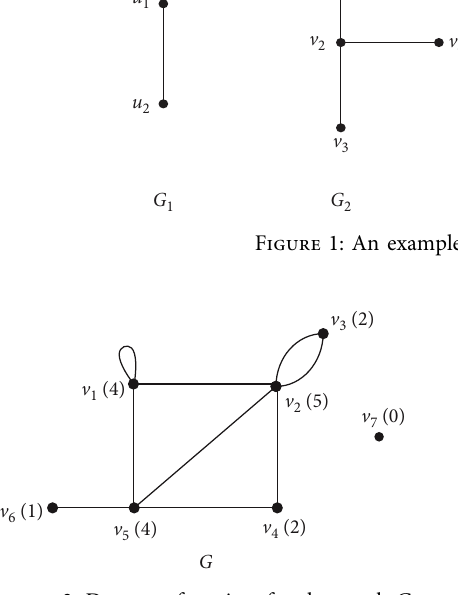
Figure 2: Degrees of vertices for the graph